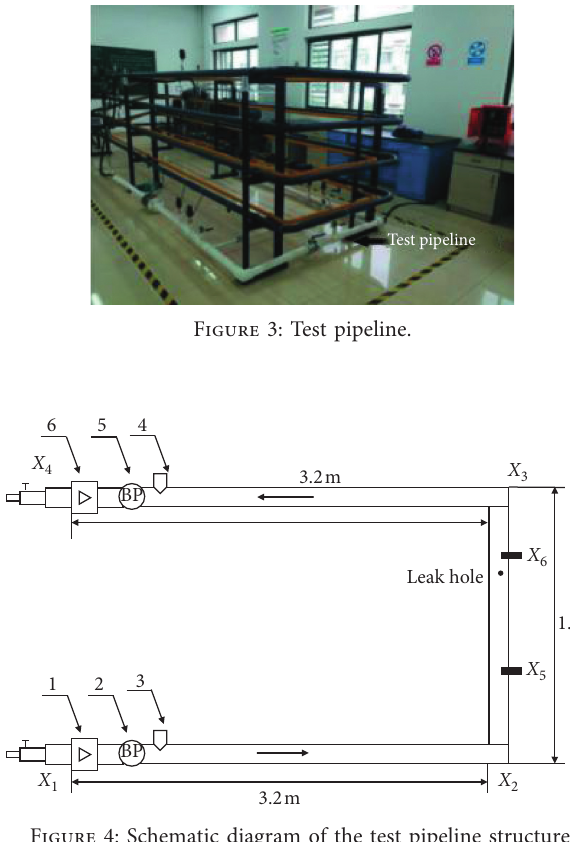
Figure 4: Schematic diagram of the test pipeline structure.